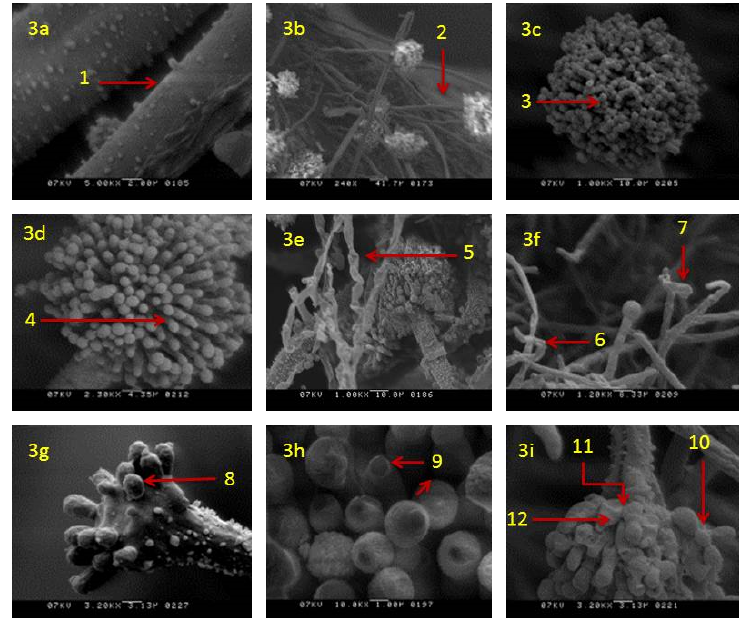
Figure 3. Scanning electron micrographs of A. flavus treated with 500 ppm of clove essential oil after seven days of incubation: ( a ) Healthy hyphae rough surface ( 1 ); ( b ) healthy hyphae with healthy conidiophore ( 2 ); ( c , d ) healthy conidium ( 3 ) and phialides ( 4 ); ( e ) treated mycelia with blistering hyphae ( 5 ); ( f ) treated hyphae with disrupted conidiophores ( 6 ) and deformed vesicles ( 7 ); ( g ) treated conidiophore with fewer or destroyed phialides on vesicle ( 8 ); ( h ) treated phialides with damage/shrunken apex ( 9 ); ( i ) treated conidiophores with disrupted conidial chain ( 10 ) collapsed vesicles ( 11 ) and phialides ( 12 ) .